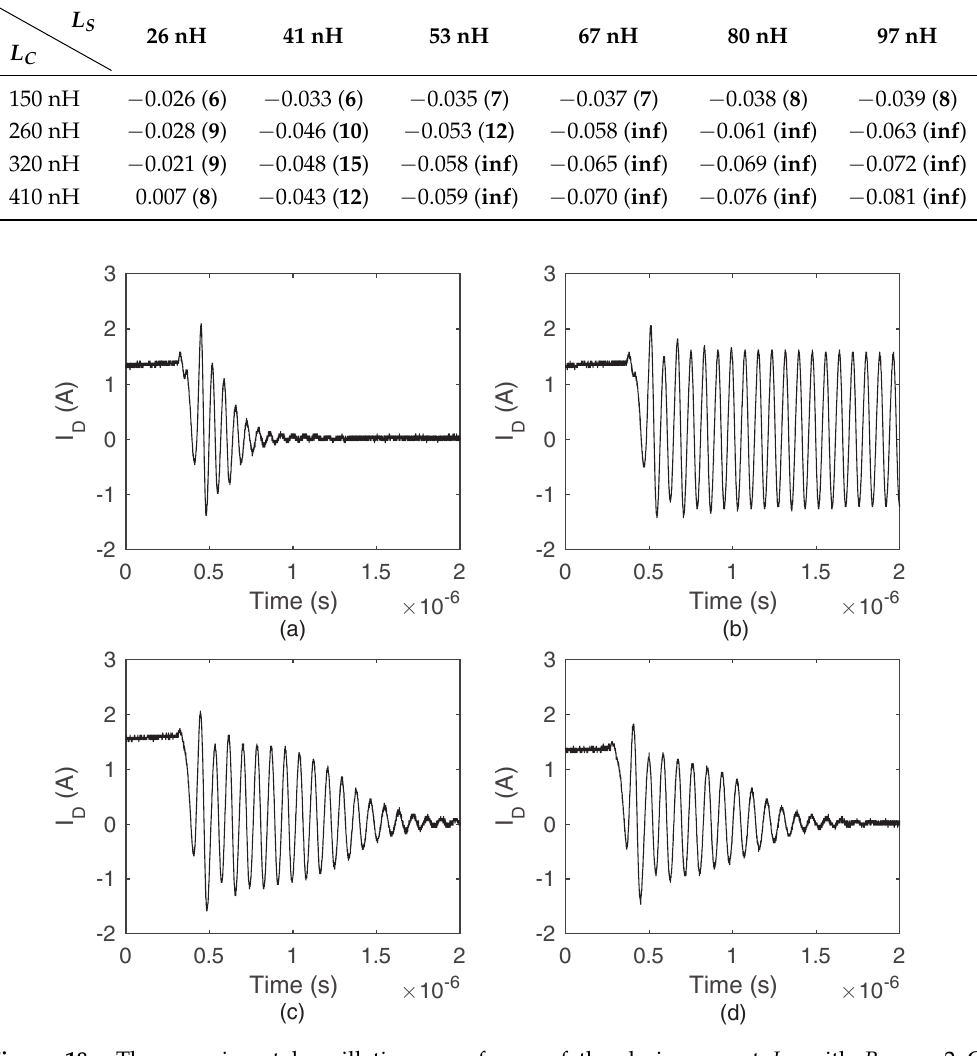
Figure 18. The experimental oscillation waveforms of the drain current I D with R G = 2 Ω . ( a ) L C = 150 nH and L S = 67 nH. ( b ) L C = 260 nH and L S = 67 nH. ( c ) L C = 320 nH and L S = 41 nH ( d ) L C = 410 nH and L S = 41